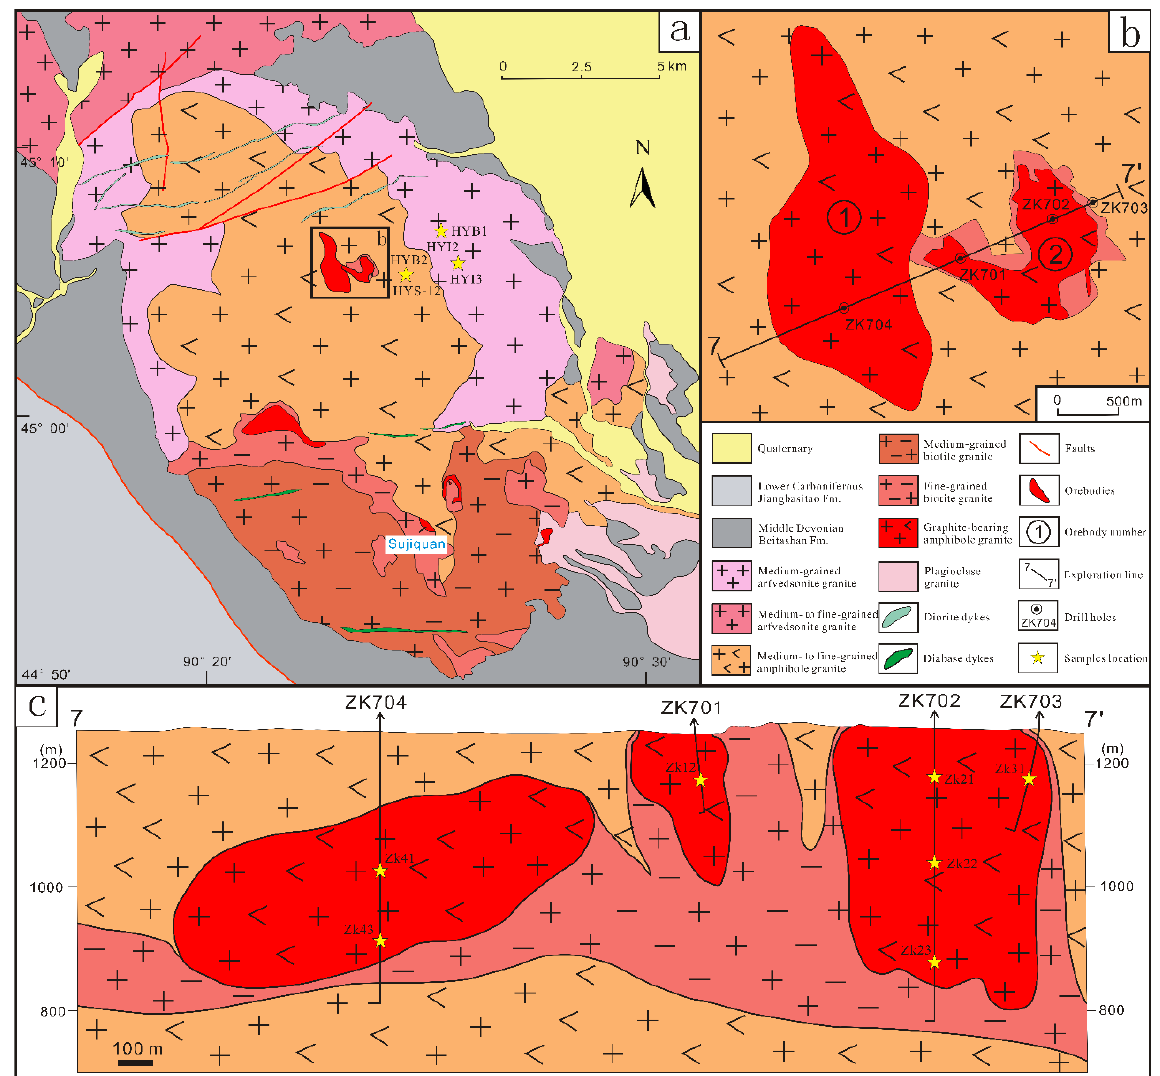
Figure 2. ( a ) Geological map of the Huangyangshan pluton (after [15]). ( b ) Simplified map of the No.1 and 2 ore bodies of the Huangyangshan graphite deposit. ( c ) Cross-section along line 7 – 7 ′ in Figure 2b (modified after [17]).